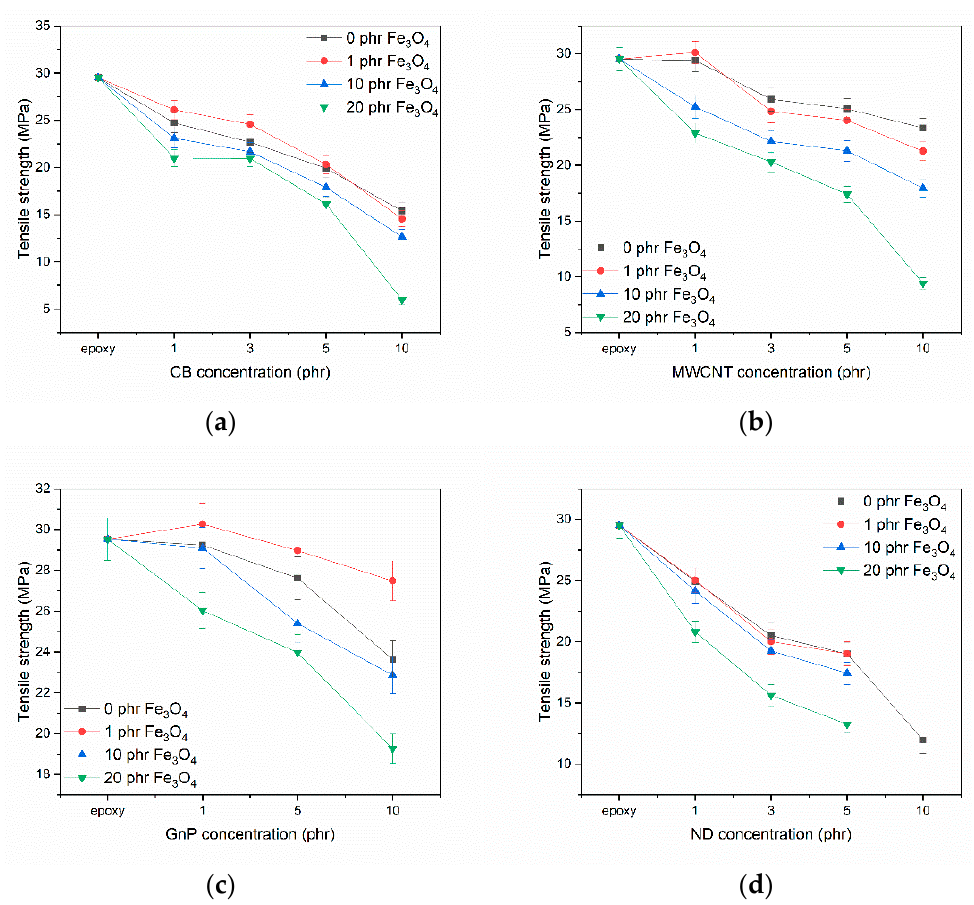
Figure 6. Tensile strength as a function of ( a ) CB; ( b ) MWCNT; ( c ) GnP; ( d ) ND concentration for all examined systems.